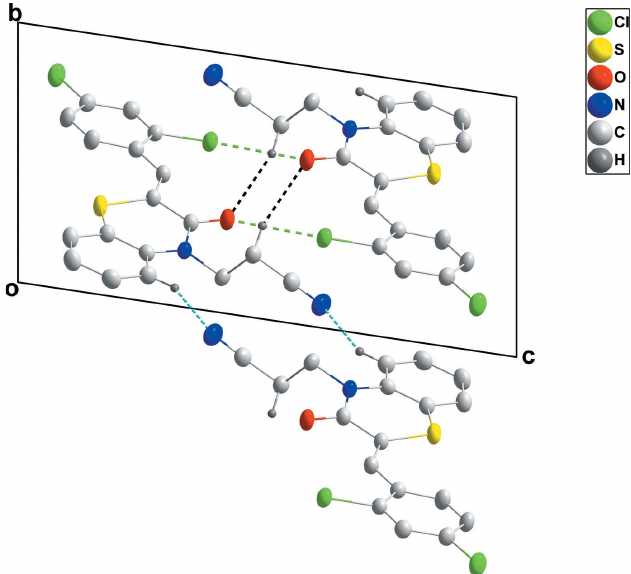
Figure 3 A partial packing diagram viewed along the a -axis direction with hydrogen bonds depicted as in Fig. 2, and C O (cid:2)(cid:2)(cid:2) Cl interactions as green dashed lines.